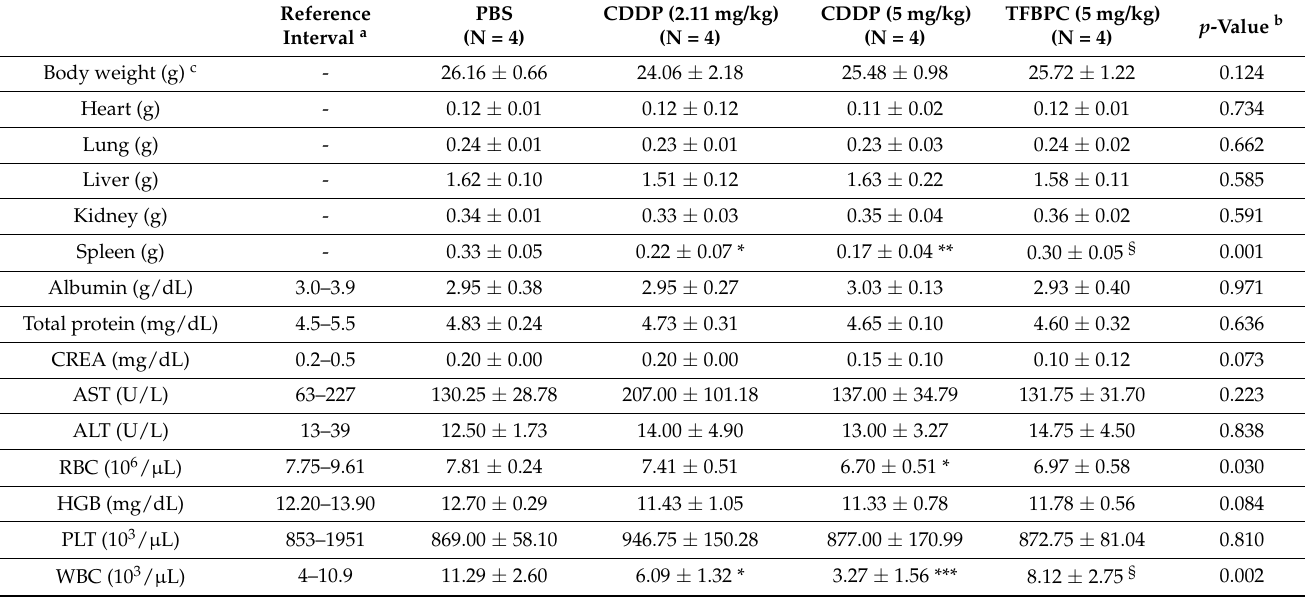
Table 4. Parameters of patient-derived xenograft